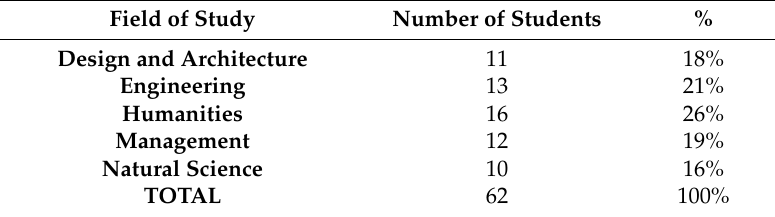
Table 3. Students who completed the programme divided according to their fields of study.